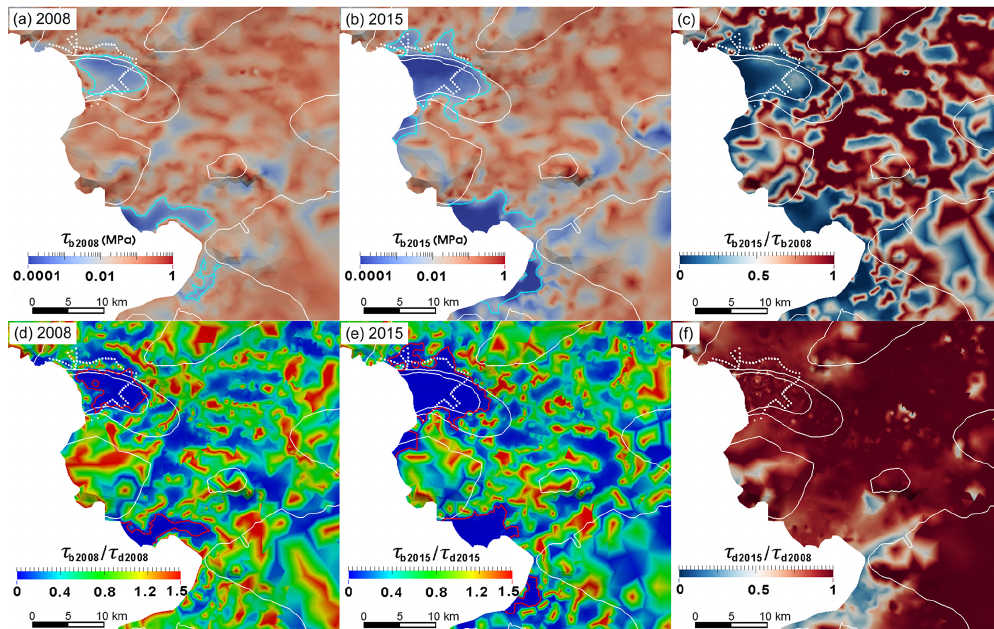
Figure 3. (a, b) Basal shear stress τ b , (d, e) the ratio of τ b to τ d , of the Fleming Glacier and the Prospect Glacier in 2008 (a, d) and 2015 (b, e) . (c) The ratio of basal shear stress τ b2015 to τ b2008 , and (f) the ratio of driving stress τ d2015 to τ d2008 . The white dotted line represents the deduced grounding line in 2014 from Friedl et al. (2018). The cyan lines in (a) and (b) show the τ b = 0 . 01MPa contour. The red lines in (d) and (e) show the RBD = 0.1 contour in the current study. The white solid lines represent the 2008 surface speed contours of 100, 1000, and 1500myr − 1 , respectively, to aid visual comparison across